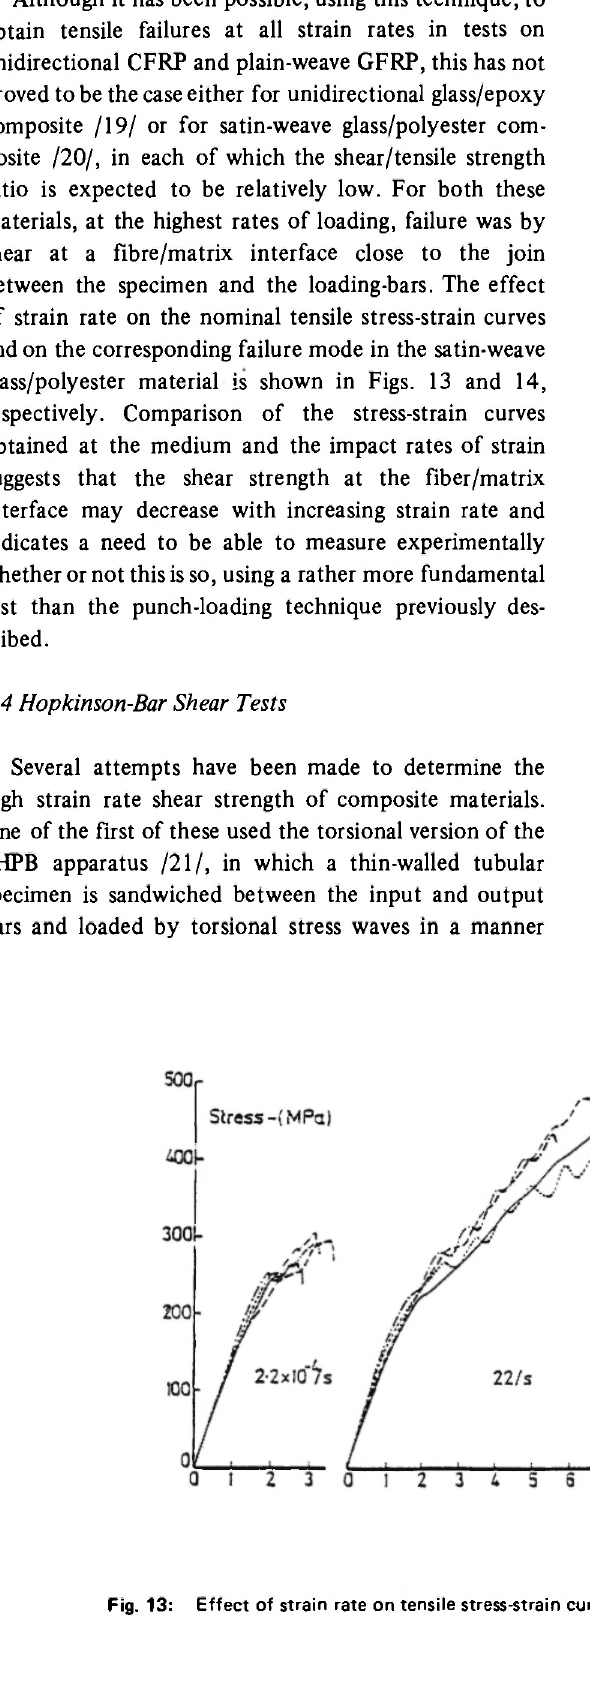
Fig. 13: Effect of strain rate on tensile stress-strain curves for satin weave glass/polyester specimens (ref.